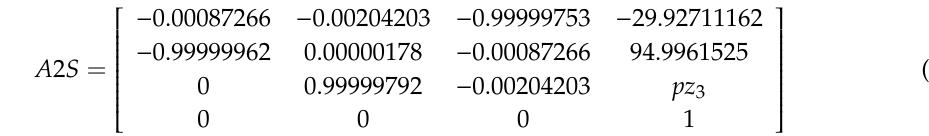
Sensors 2019 , 19 , x FOR PEER REVIEW